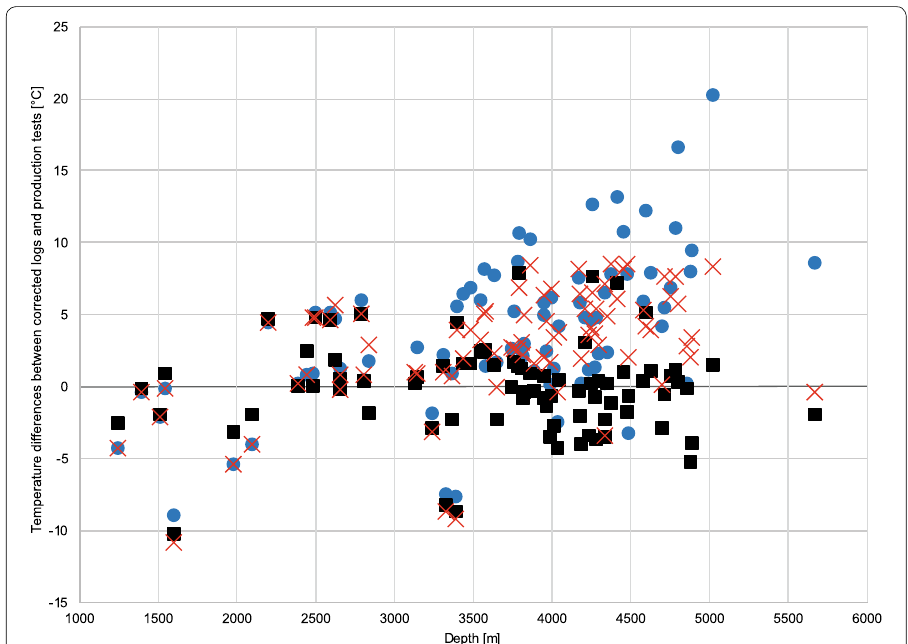
Fig. 8 Differences between measured production test temperatures and predicted temperatures from corrected logs. Blue dots: method A; black squares: method B; red crosses: method C